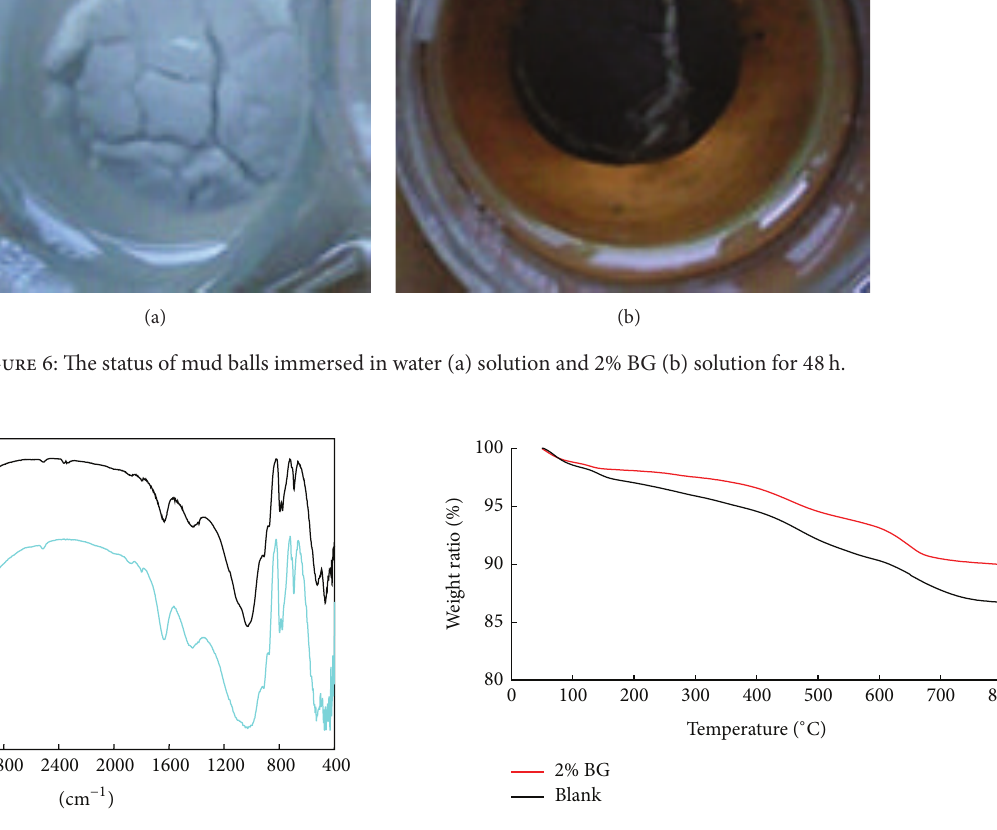
Figure 8: The TGA of the montmorillonite treated by water and BG